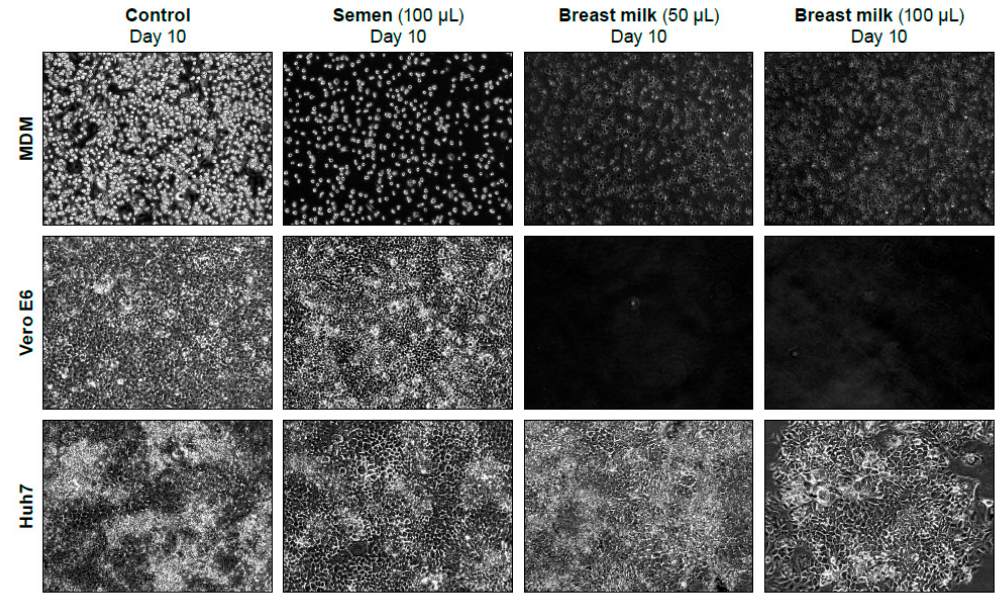
Figure 5. 10 × images of MDM, Vero E6, and Huh-7 cells taken 10 days following exposure to select volumes of normal semen, breast milk, or cell culture media (control). Breast milk was toxic at 50 and 100 µ L/T-25 flask on Vero E6 cells (no cells present after 10 days) and MDM cells, but toxicity was less on these cells than on Huh7 cells.